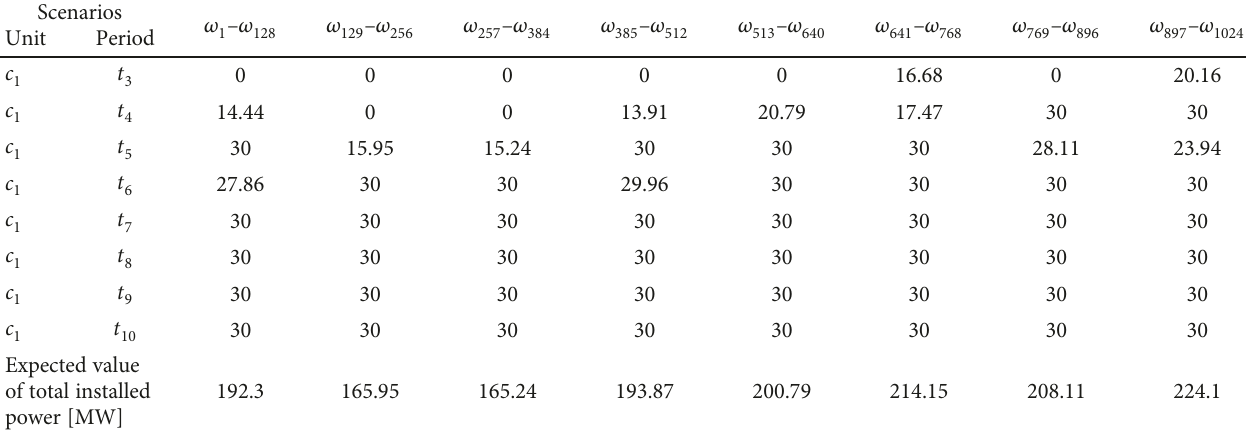
Table 16: Expected value of the installed capacity for the conventional candidate energy [MW].